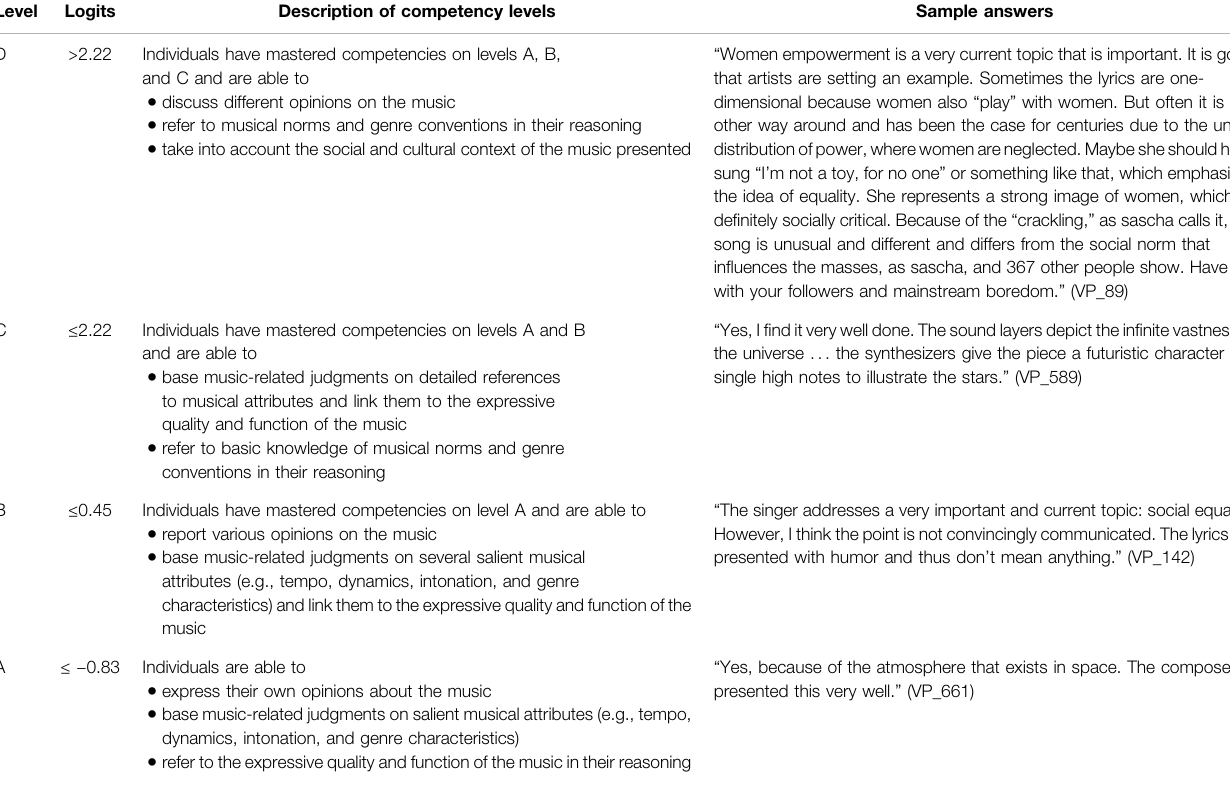
TABLE 3 | Description of the competency levels. The sample answers are taken from the two sample items, “ Star Wars ” ( Figure 1 ) and “ Eurovision Song Contest ” (see section 1 in the Supplementary Material ; solution probability 65%). The second column ( “ Logits ” ) refers to the person ability scores (weighted likelihood estimation [WLE]). The table is supposed to be read from bottom to